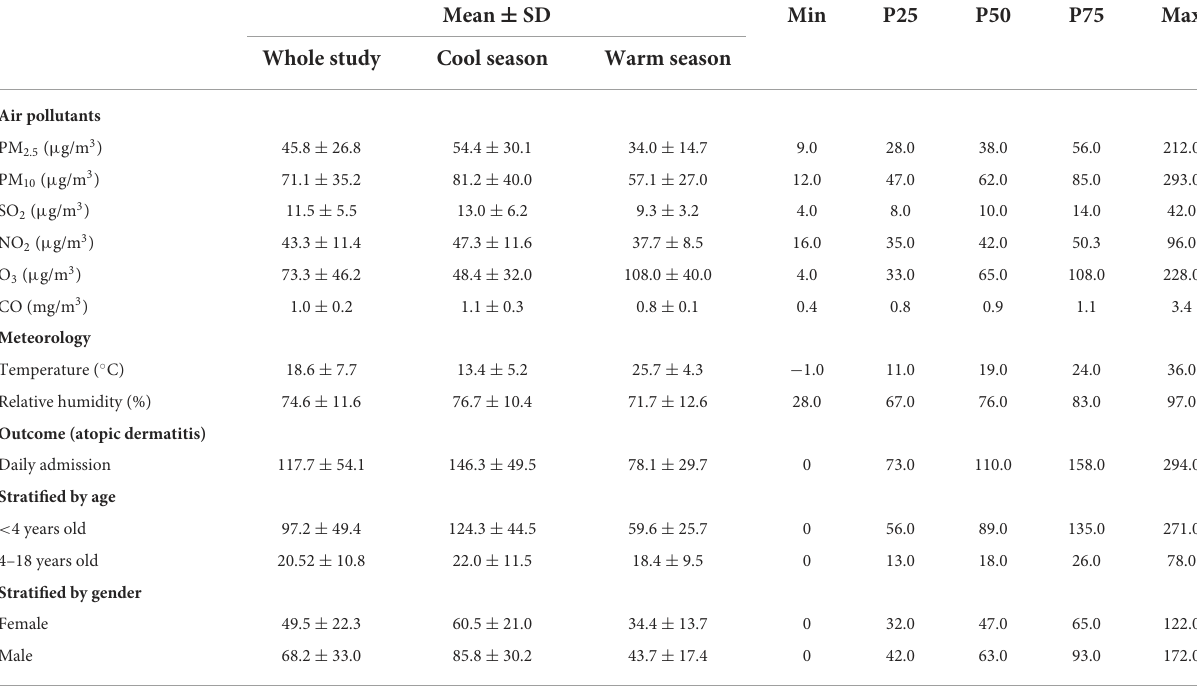
TABLE 1 Daily air pollution, meteorological data, and outpatient visits for AD in Chongqing, China, from January 1, 2015, to December 30, 2019. Mean ± SD Min P25 P50 P75 Max Whole study